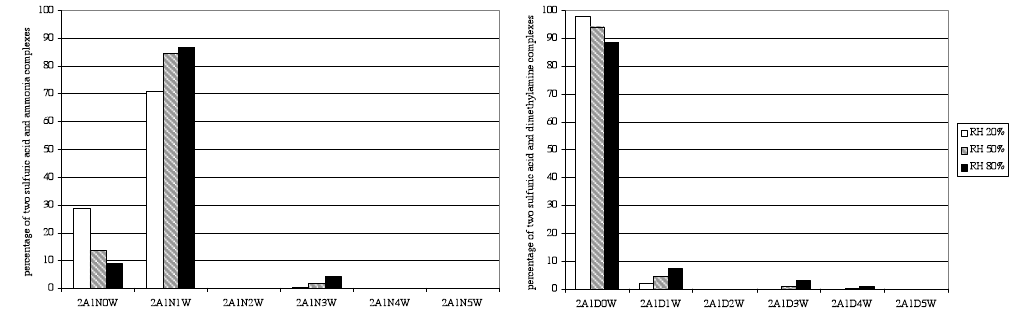
Fig. 10. Hydrate distributions of clusters with two sulfuric acid and ammonia (left) and clusters with two sulfuric acid and dimethylamine (right) at three different relative humidities. 2A1NxW ≡ ( H 2 SO 4 ) 2 · NH 3 · ( H 2 O ) x and 2A1DxW ≡ ( H 2 SO 4 ) 2 · ( CH 3 ) 2 NH · ( H 2 O ) x . In all cases T = 298 .